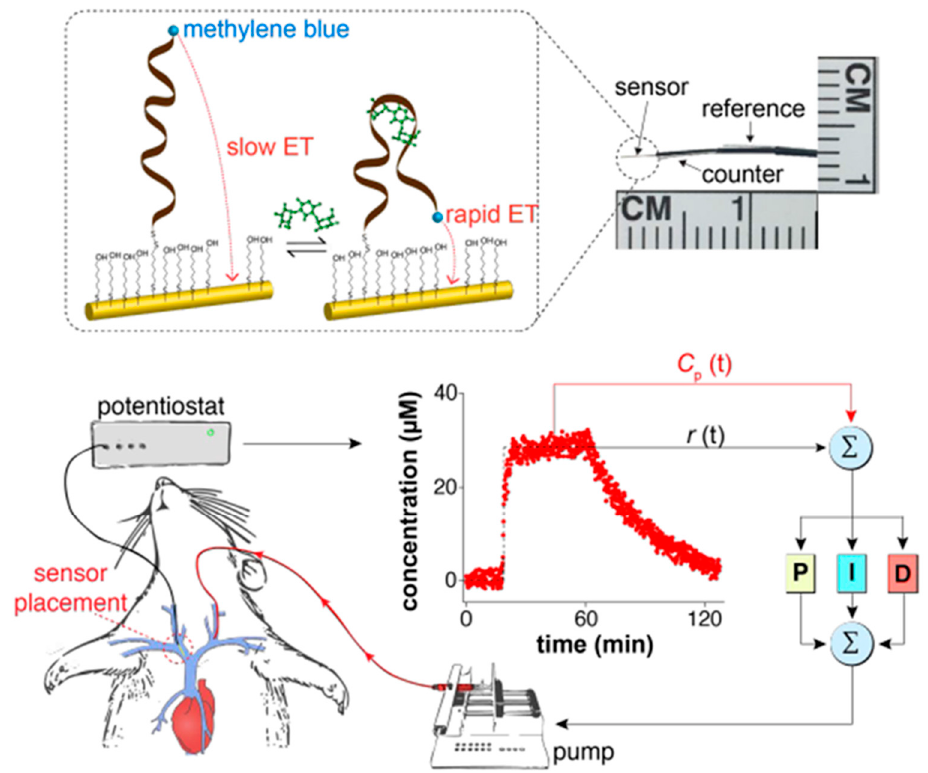
Figure 5. E-AB sensor implanted in the jugular of rats to monitor drug levels in vivo. Reprinted and adapted from [11] with permission.